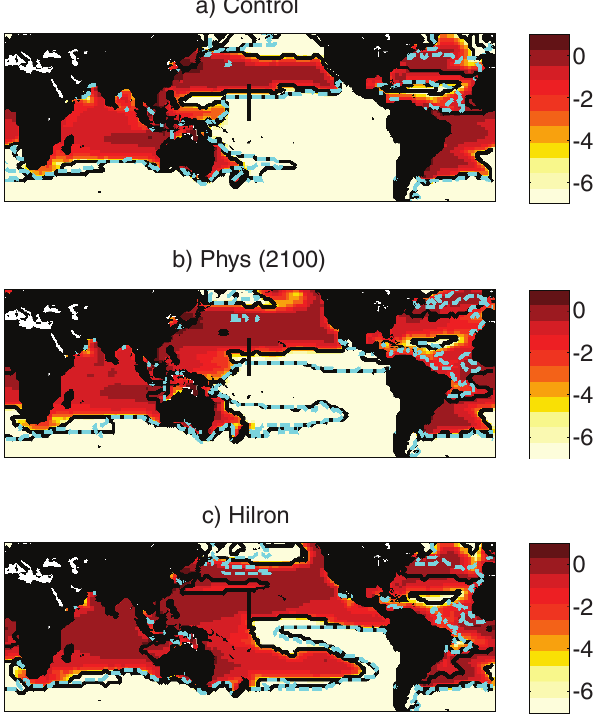
Figure 2. Nitrogen fixation rates (loggNm − 2 yr − 1 , annual aver- age) for (a) pre-industrial conditions (experiment Control ); (b) 2100 conditions if physical fields, including ocean temperature change in a business as usual emission scenario but with pre-industrial iron dust supply (experiment Phys ); (c) conditions if physical fields re- main as if for pre-industrial, but iron dust supply is doubled (experi- ment HiIron ). Dashed blue line bounds regions where both φ PN > 1 and φ FeN > 1 (discussed in Section 3.3). Black contours indicate the province boundaries in Fig. 3. Black line in Pacific indicates the transect show in Figs. 4 and 8.